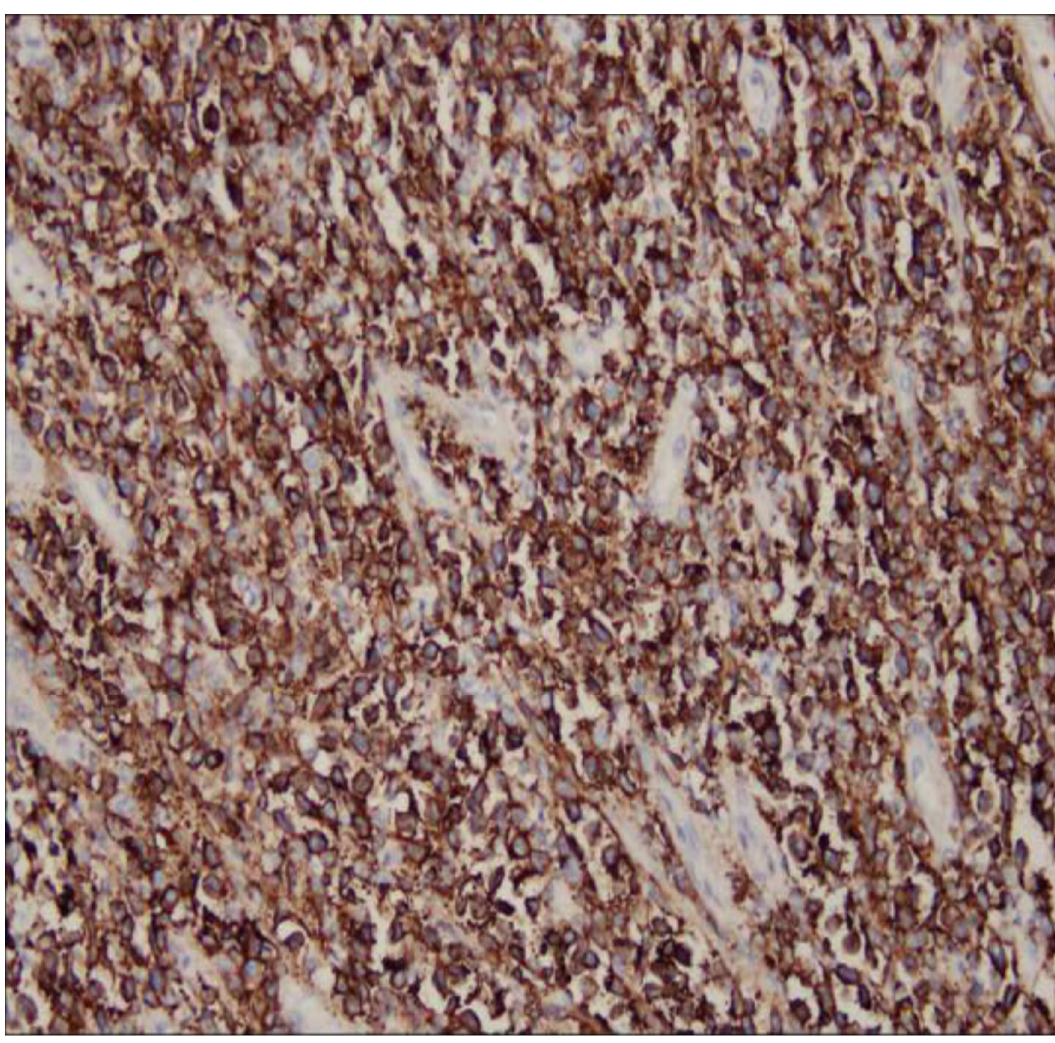
Figure 5. Immunohistochemical testing was positive for CD20. Lymphoma is the most common malignancy of the spleen, but primary lymphoma of the spleen is very rare with an incidence rate of <1% under the strict criteria for diagno ‐ sis expounded by Das Gupta et al. According to their criteria, diagnosis of primary splenic lymphoma should only be made when the disease is confined to the spleen but may also involve the hilar lymph nodes with no recurrence of the disease after splenectomy [1–3]. In our case, the patient presented with a large splenic cystic tumor that did not affect other organs, and there was no occurrence after splenectomy and chemotherapy.